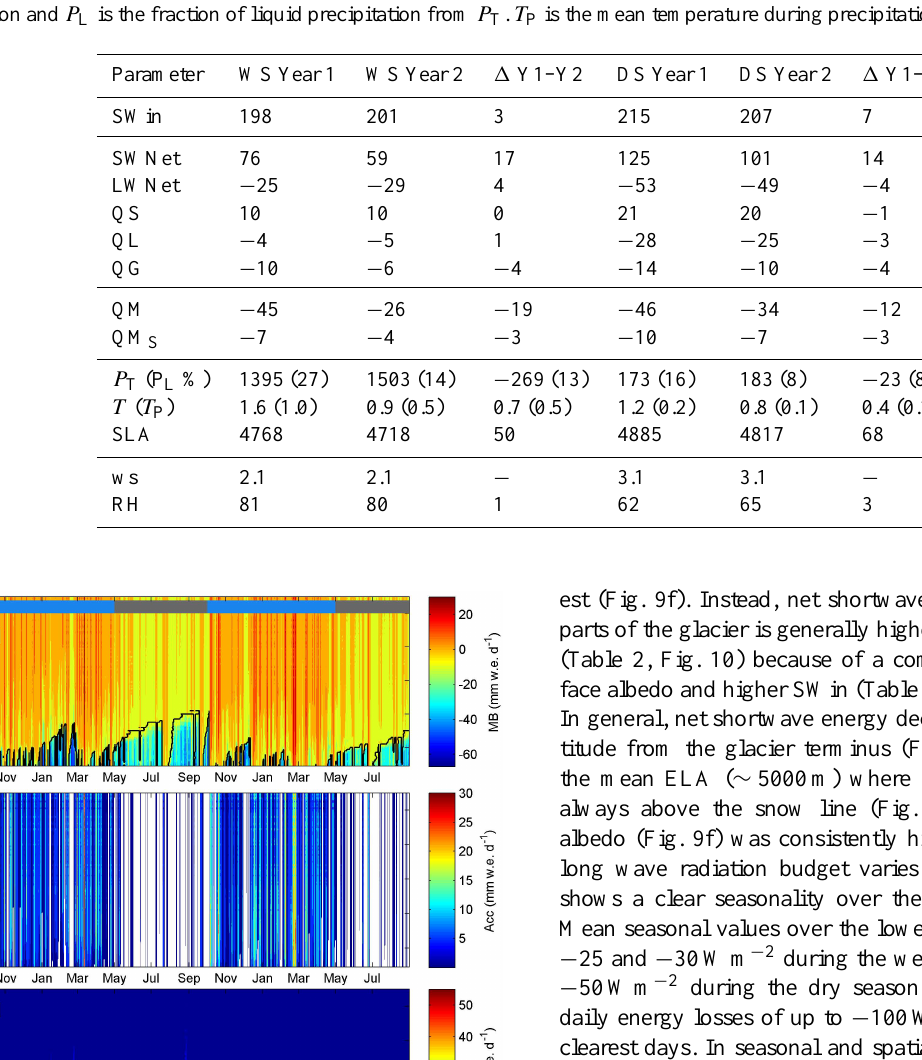
Table 2. Seasonal mean values of SWin (Wm − 2 ), the energy balance terms (all Wm − 2 ), precipitation (mmw.e.), temperature ( ◦ C), snow WS is the wet season (October–April) and DS is the dry season (May–September). QM S is the melt energy in the subsurface. P T is all phase precipitation and P L is the fraction of liquid precipitation from P T . T P is the mean temperature during precipitation.